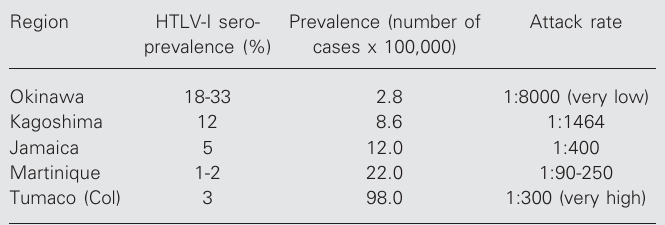
Table 1. Paradoxical epidemiology of tropical spastic paraparesis/HTLV-I- associated myelopathy